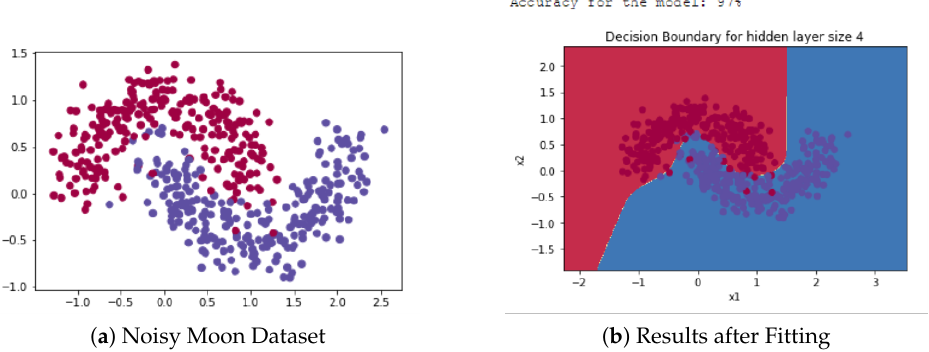
Figure 12. Visualization of the noisy moon dataset and results after fitting the DTBDNN model into the noisy moon dataset.